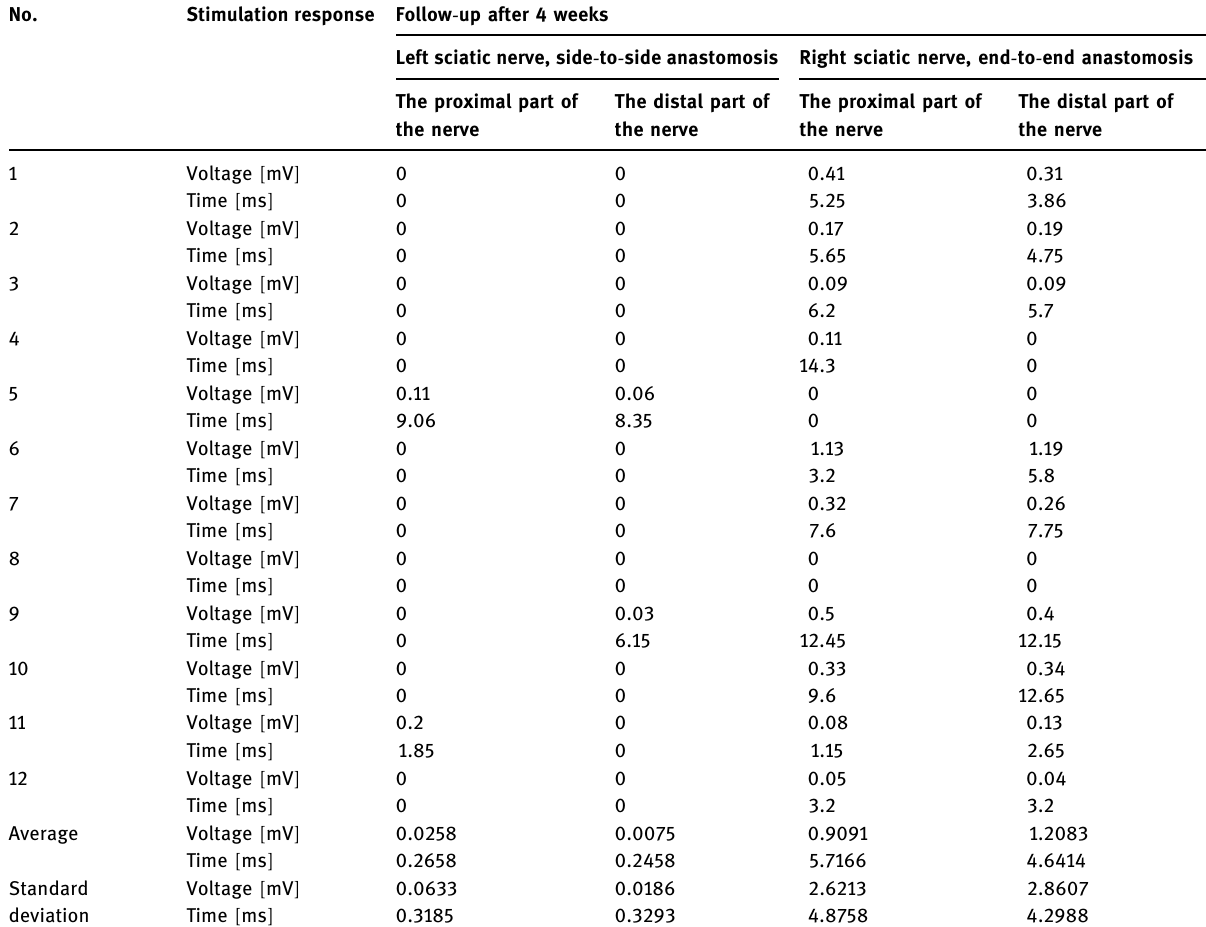
Table 4: The electrophysiological study parameters conducted after stimulating the sciatic nerves 4 weeks after the nerve anastomosis was performed